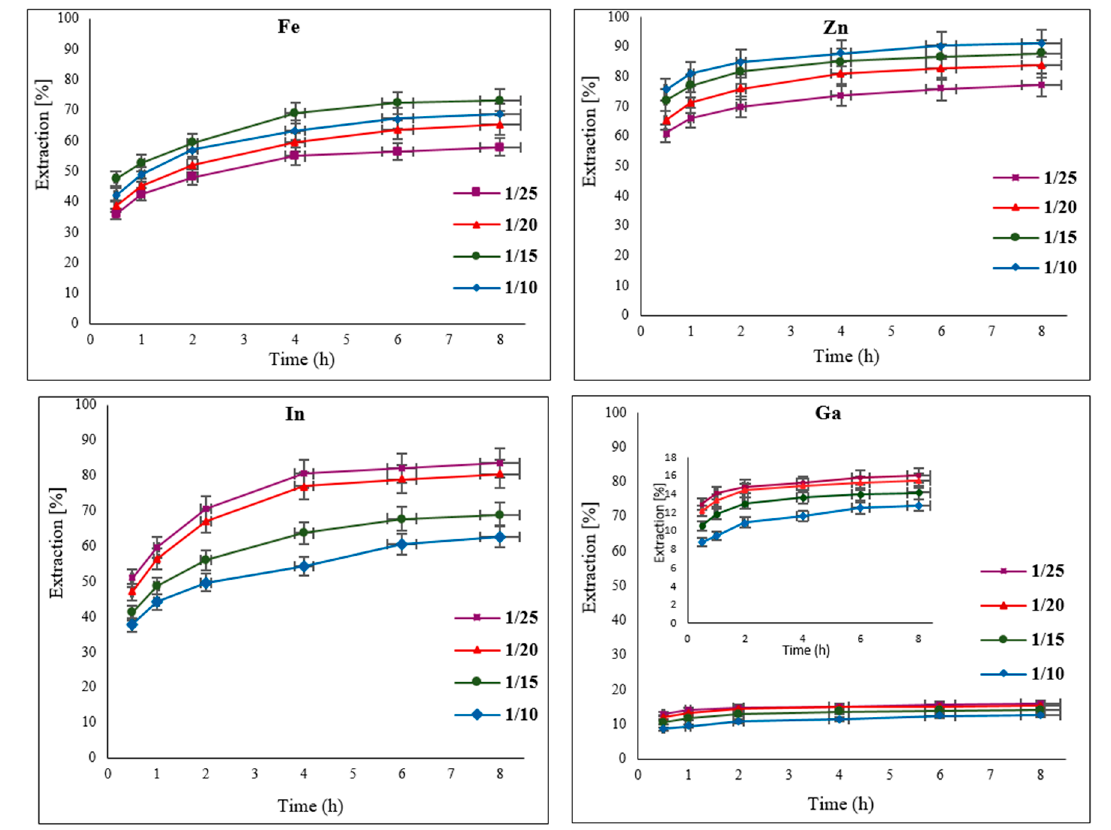
Figure 7. Effect of different solid-to-liquid (S/L) ratios (1/25, 1/20, 1/15, and 1/10) on the extraction of Fe, Zn, In, and Ga from EAFD. Experimental conditions: 50 mL of 30% v/v [Bmim + HSO 4 − ], 1 g of oxidant Fe 2 (SO 4 ) 3 , stirring speed of 500 rpm, temperature of 65 °C, total leaching time of 8 h.